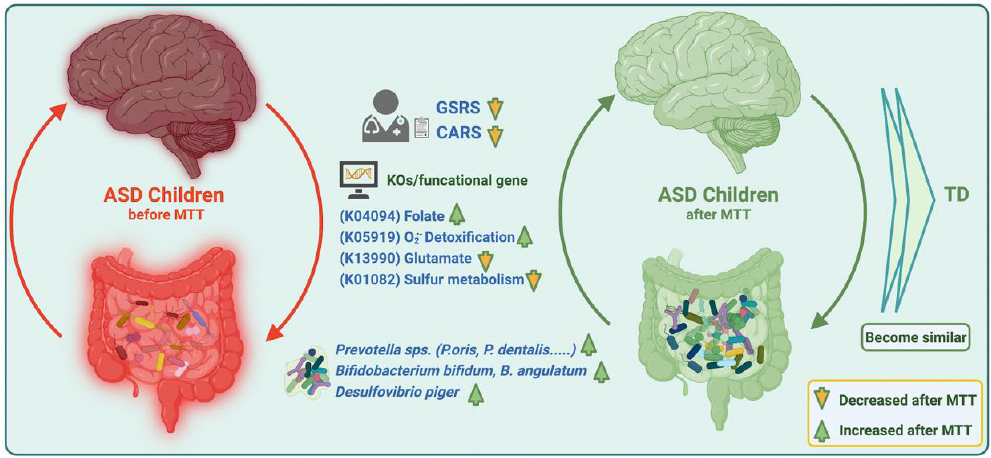
Figure 9. Overview illustration of microbiome and metabolic pathways/KOs in children with ASD before and after MTT. Gastrointestinal Symptom Rating Scale (GSRS); Childhood Autism Rating Scale (CARS).